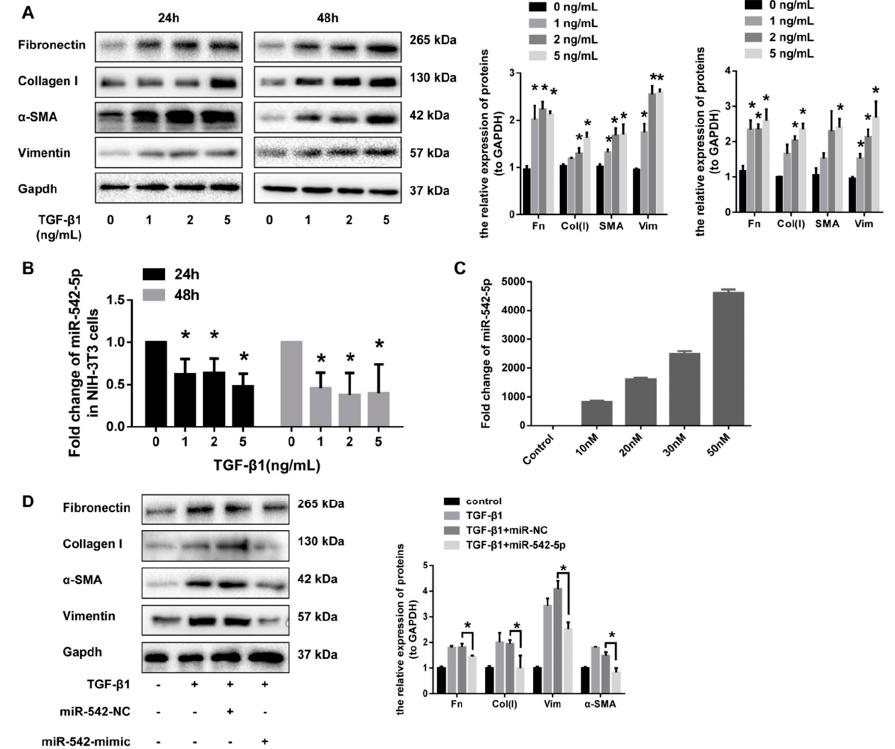
Figure 4. miR-542-5p blocked the activity of NIH-3T3 cells in vitro. ( A ) The protein expression levels of fibronectin, vimentin and α -SMA were obviously elevated in NIH-3T3 cells when treated with an increased dose of TGF- β 1 (0, 1, 2, 5 ng/mL) for 24 h or 48 h. The results of Western blot were analyzed by ImageJ software, * p < 0.05 versus the control group. ( B ) The miR-542-5p expression levels were significantly decreased in NIH-3T3 cells treated with different doses of TGF- β 1 (0, 1, 2, 5 ng/mL) for 24 h or 48 h, * p < 0.05 versus the control group. ( C ) miR-542-5p mimics transfection efficiency. Different concentrations (10 nM, 20 nM, 30 nM, 50 nM) of miR-542-5p mimic showed different transfection efficiencies and 30 nM was chosen in this study to optimize the experiment. ( D ) Western blot analysis was performed to detect the fibrosis markers (fibronectin, collagen I, α -SMA and vimentin) in NIH-3T3 cells pretreated with miR-542-5p mimics (30 nM) for 24 h, followed by TGF- β 1 (5 ng/mL) for 48 h. * p < 0.05 versus the TGF- β 1 + mimic-NC group.